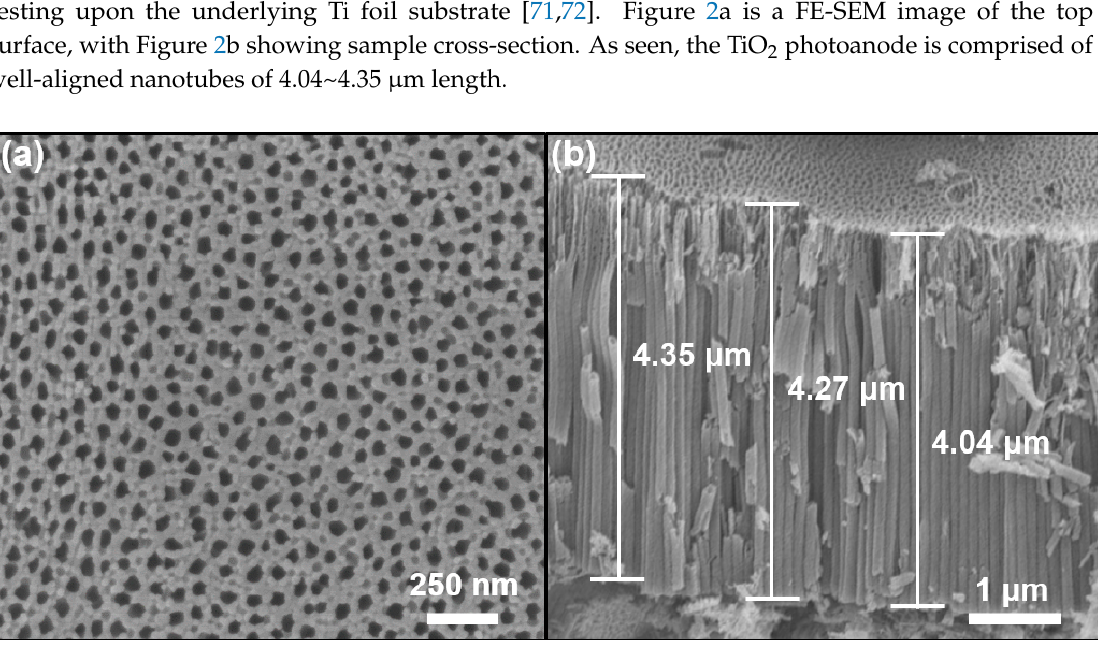
Figure 2. ( a ) Surface and ( b ) cross-sectional field emission scanning electron microscope (FE-SEM) images of TiO 2 nanotube (TNT).